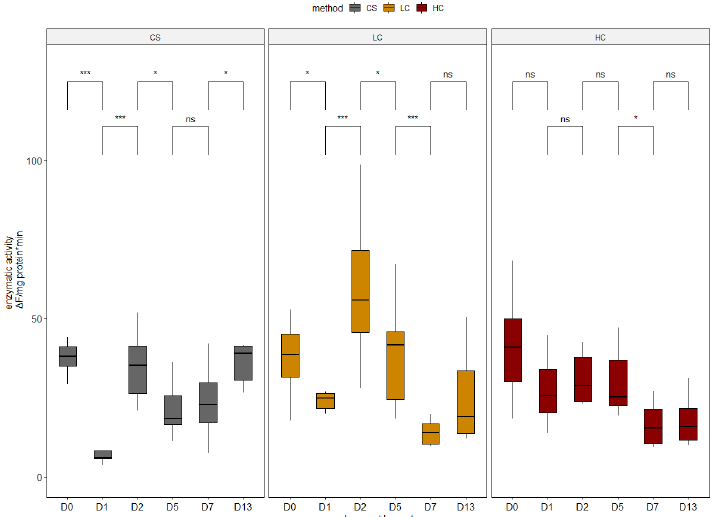
Figure 3. Enzymatic activity of cathepsin L in all sampling days per harvest method. CS (gray): control group, LC (orange): low current group, HC (red): high current group. Superscripts indicate statistically significant differences between days in each harvest method (ns: p > 0.05, *: p < 0.05, ***: p < 0.001). Different patterns of activation were observed in cathepsin B (Figure 4). HC speci- mens exhibited the lowest activity on harvest day (day 0), and after a peak on days 1 and